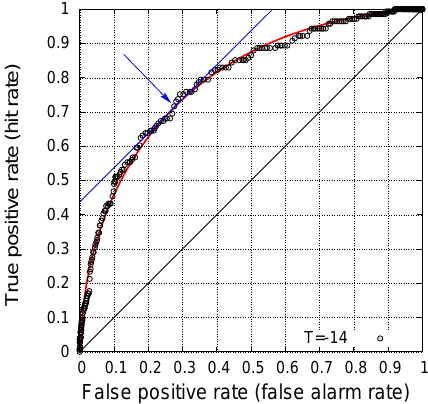
Figure 2. The hit rate vs. false alarm rate when using (cid:49)S 20 as a pre- dictor for the SOI value of the next month. The ROC point indicated by the arrow has been selected so that the slope of the tangent of the analytical fitting of the ROC points indicated by the red curve has unit slope and hence it corresponds to the m = 1 iso-performance line of the ROC space (e.g., see Fawcett, 2006; Provost and Fawcett, 1998,